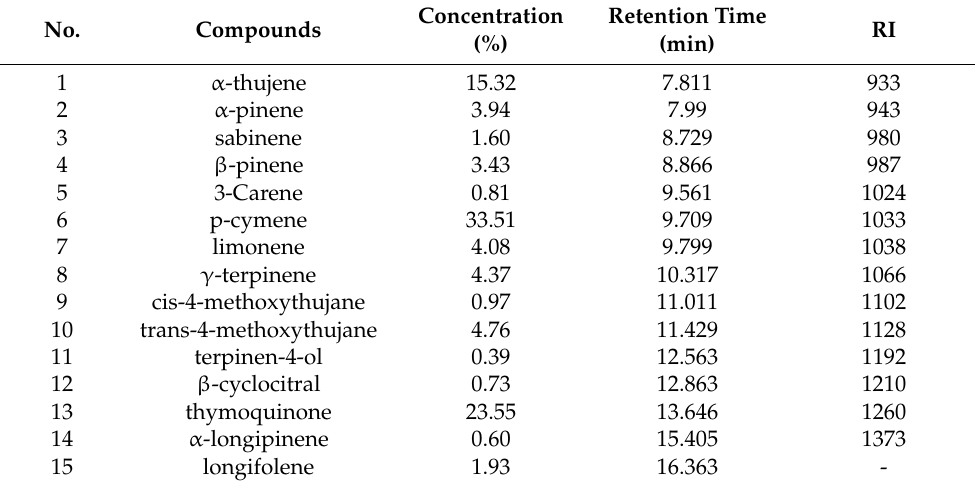
Table 1. Chemical composition of essential black cumin oil.